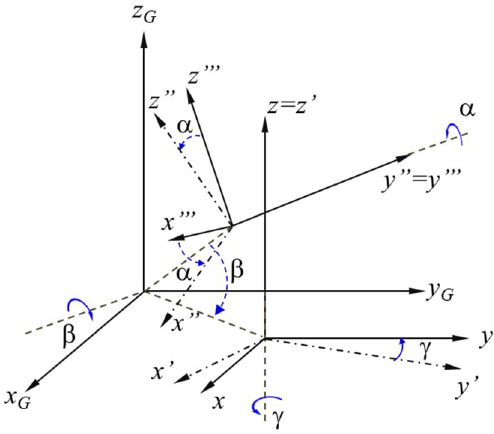
Figure 18. Representation of the displacement of the coordinate system with the help of Euler’s angles.